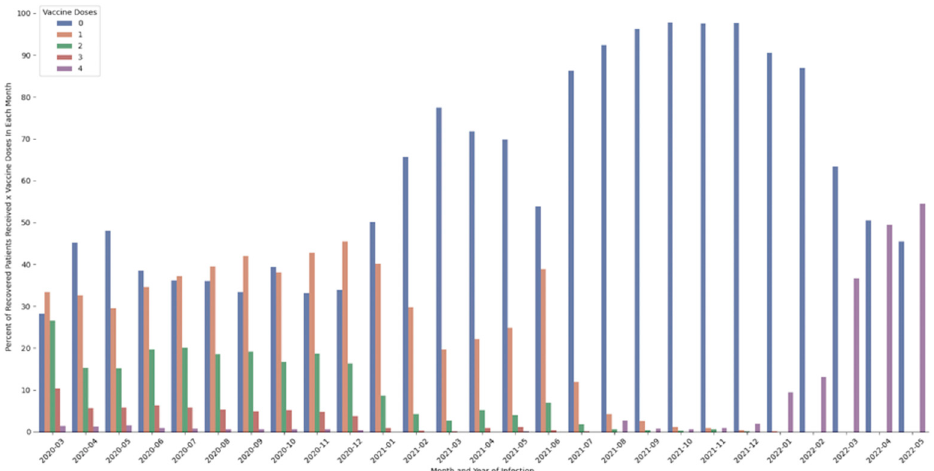
Figure 1. Per-month infection (year-month), percentage of recovered patients according to number of vaccine doses received. Note: data only include recovered patients who received no vaccine doses prior to infection.